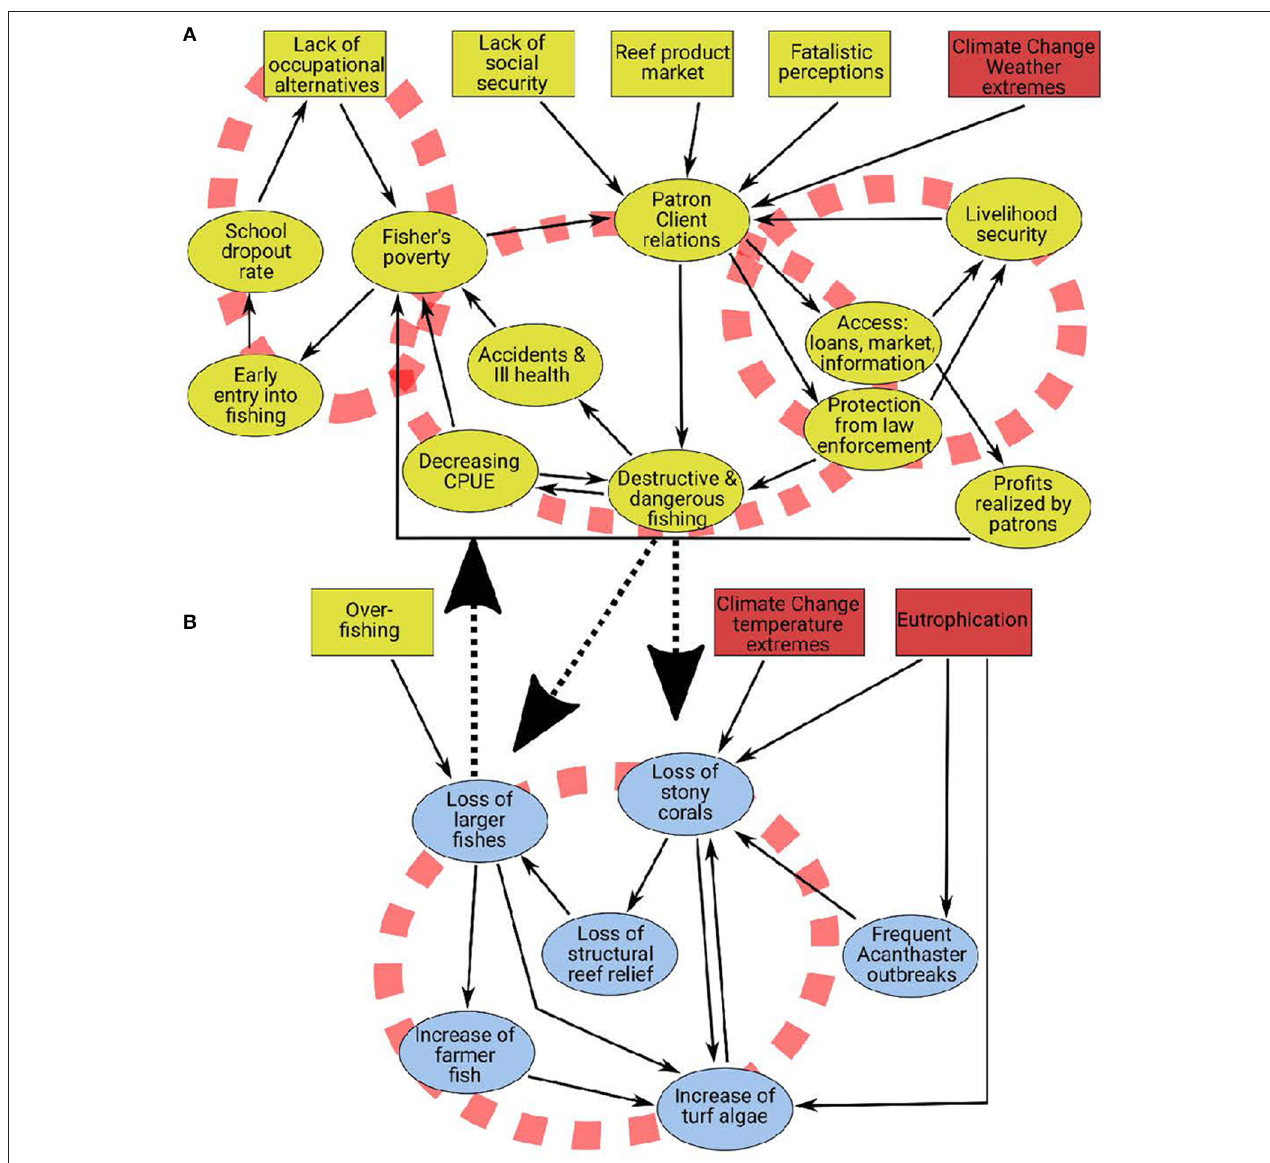
FIGURE 1 | Interlocking social-ecological cycles in reef fisheries in Spermonde Archipelago. (A) Social dynamics with three vicious cycles. (B) Ecological dynamics with one vicious